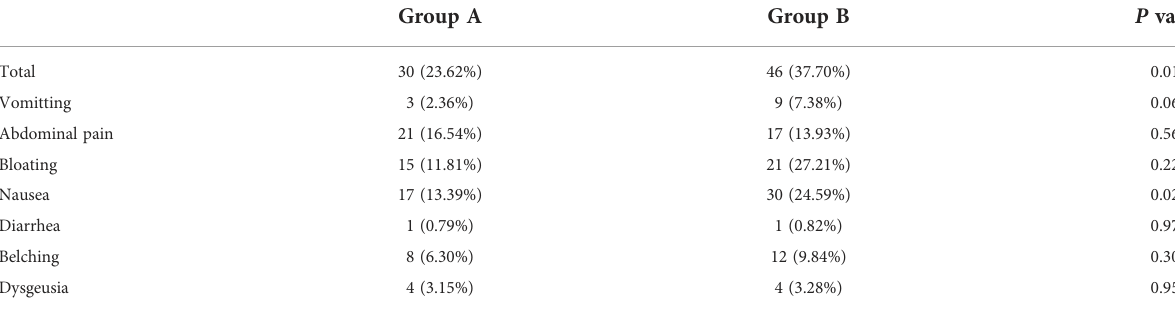
TABLE 2 Gastrointestinal side effects of patients treated with probiotics (A) or placebo (B) during eradication therapy. Group